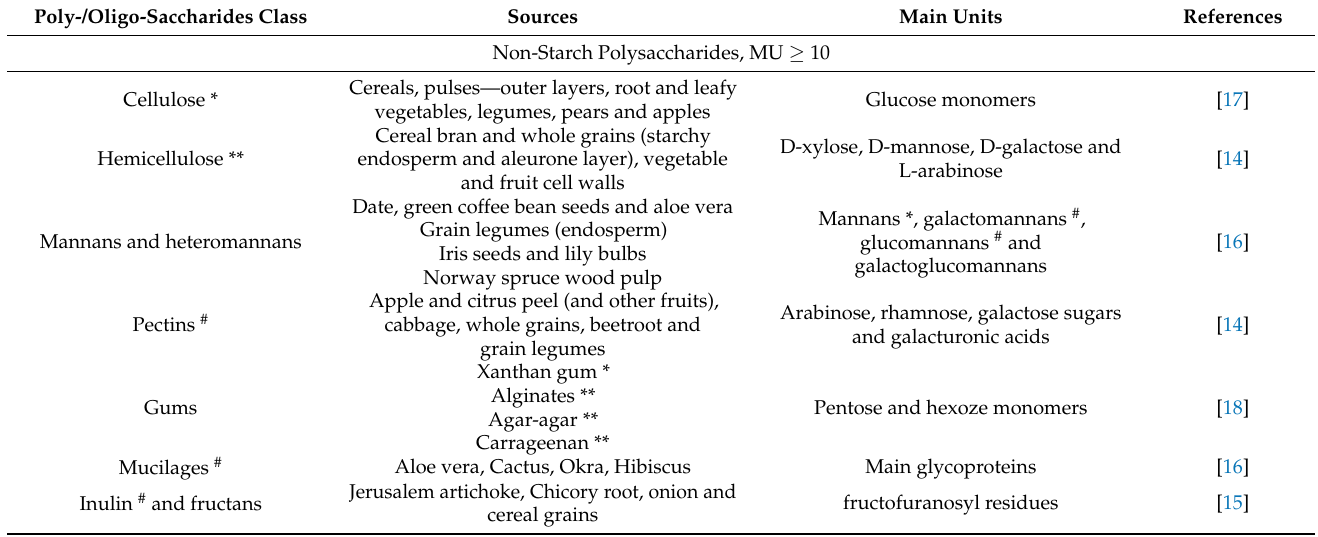
Table 1. The classification of dietary fibers according to the composition, properties and main sources